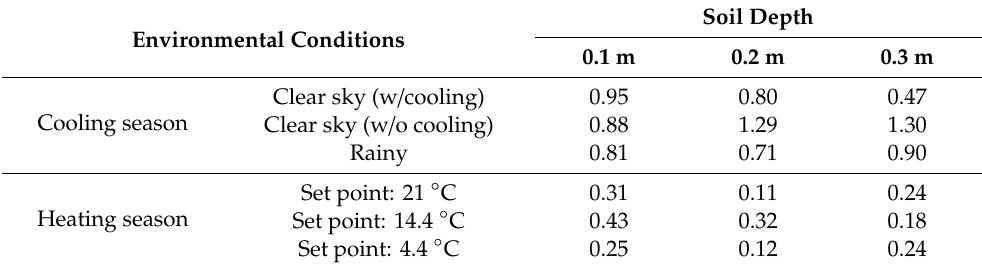
Table 2. Performance of the soil temperature prediction model under di ff erent environmental conditions. The values in the table are the Root Mean Square Error (RMSE) of the model predictions and actual